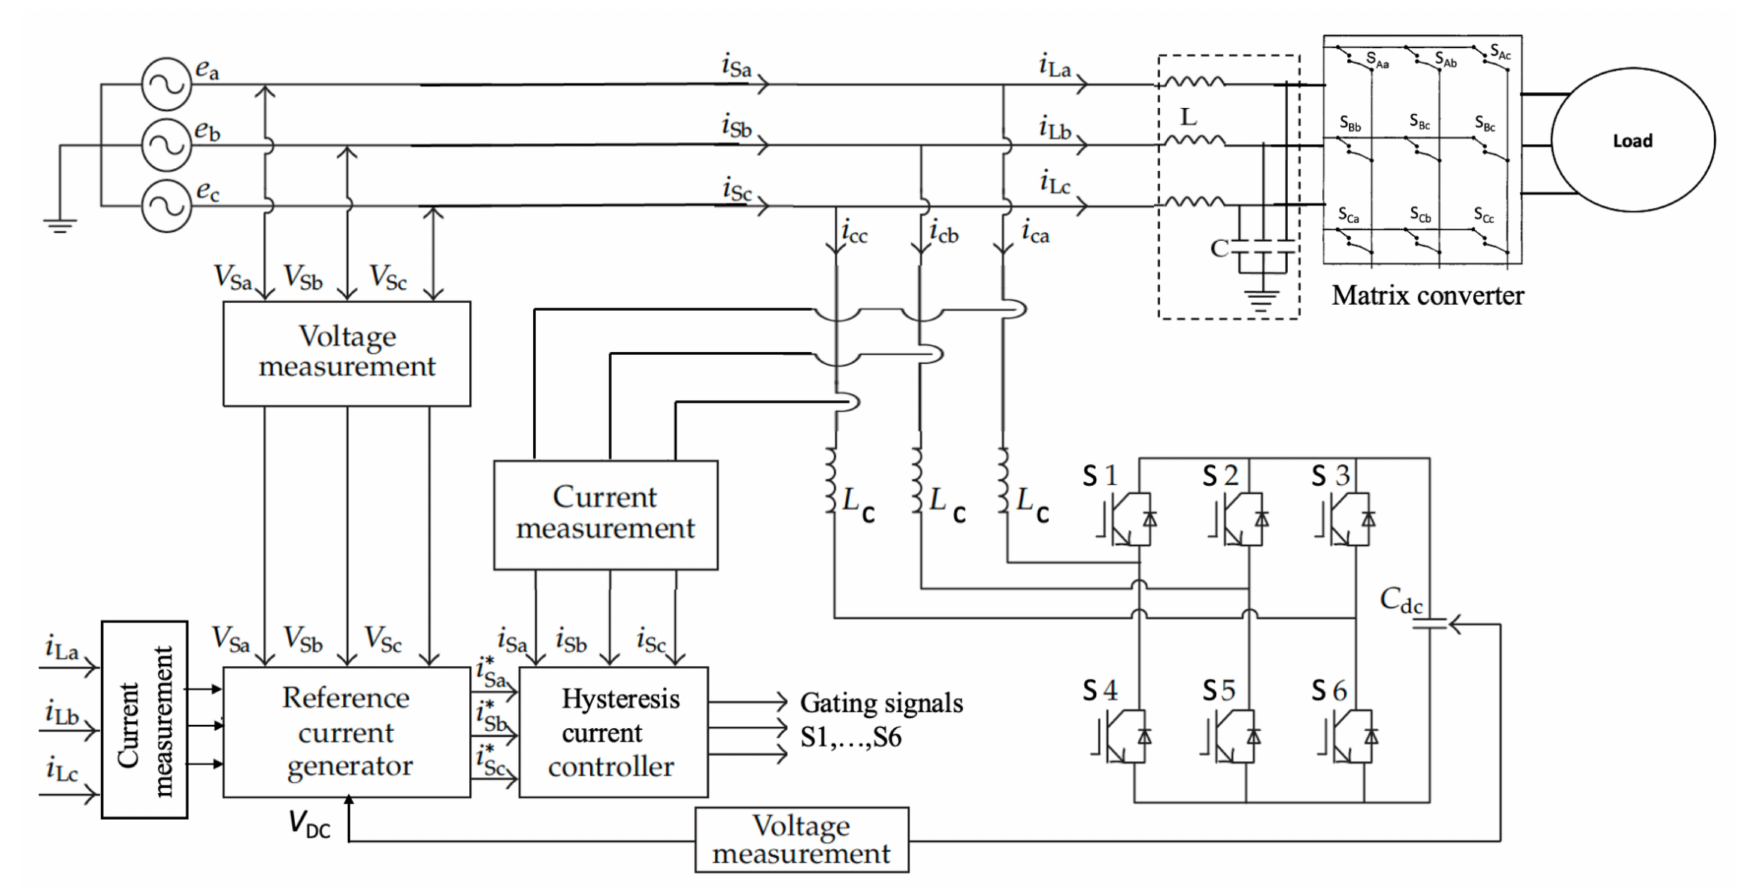
Figure 9. FIS-controlled HAPF architecture in MATLAB/Simulink